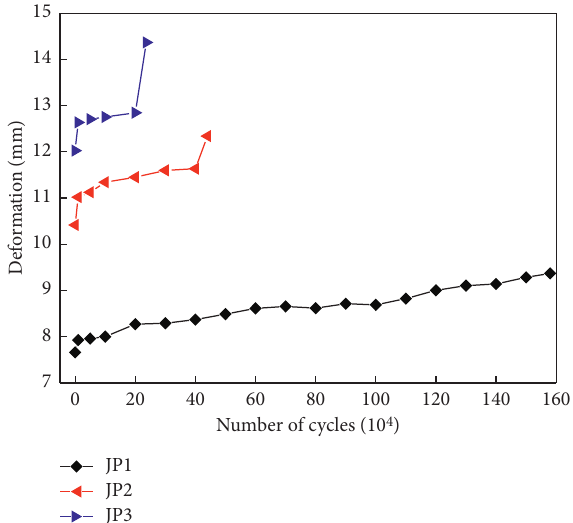
Figure 13: Relation curve for deflection and fatigue